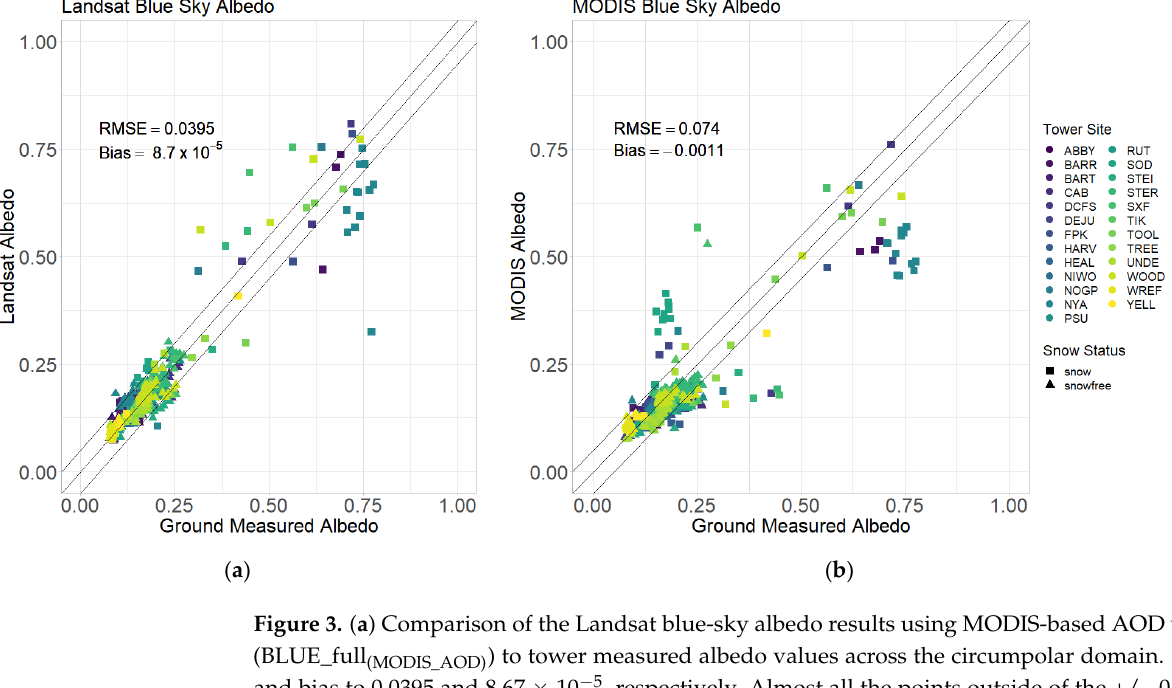
Figure 3. ( a ) Comparison of the Landsat blue-sky albedo results using MODIS-based AOD values (BLUE_full (MODIS_AOD) ) to tower measured albedo values across the circumpolar domain. RMSE and bias to 0.0395 and 8.67 × 10 − 5 , respectively. Almost all the points outside of the +/ − 0.05 are scenes where snow is present in the footprint, highlighting the need for further development of high-resolution products to capture these conditions. ( b ) Comparison of the MODIS blue-sky albedo results to tower measured albedo values at both spatially representative and non-representative sites for the spatial resolution of the MODIS sensors across the circumpolar domain. RMSE and bias to 0.074 and − 0.0011, respectively. Again, most points outside the +/ − 0.05 are scenes in which snow is present, with Ny-Alesund and Sodankylä being especially poorly captured by MODIS albedo.